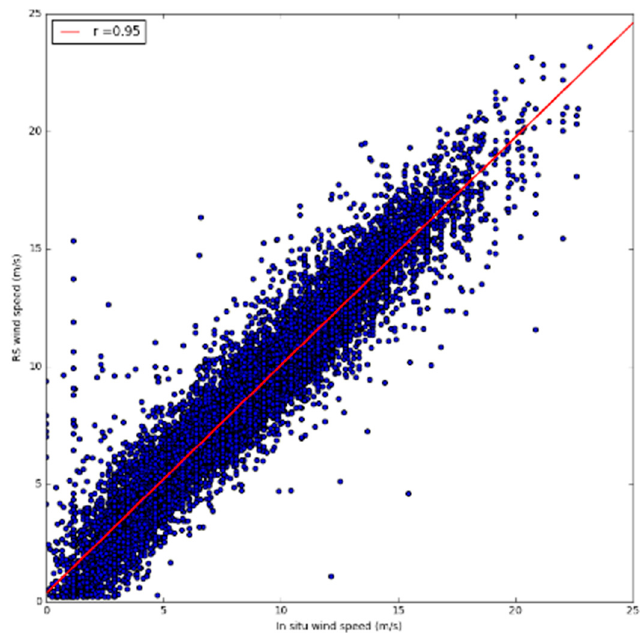
Figure 2. Scatter plot and regression line of the in situ and remotely sensed wind speed (m s − 1 ) from all the weather buoy locations (n = 14,157). Table 2. Statistical comparison of Advanced Scatterometer (ASCAT) data and in situ measurements including: number of observations (n), the mean (m s − 1 ), and standard deviation (Stdv) (m s − 1 ) of